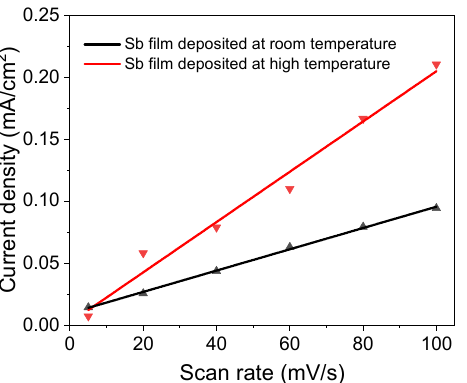
Figure 6. Electrochemical active surface area test of Sb nanofilms deposited at different tempera ‐ tures.